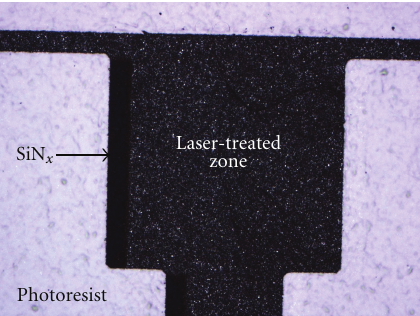
Figure 5: Image of the misalignment between the laser-treated zone and the metal contact